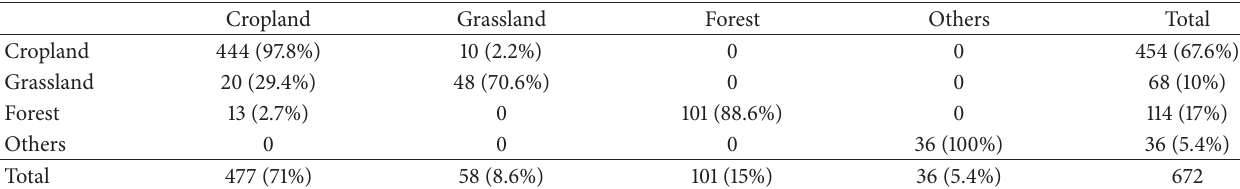
Table 2: Transition matrix of LUCC with grid count and percent in Central Europe during 2010 to 2050. Cropland Grassland